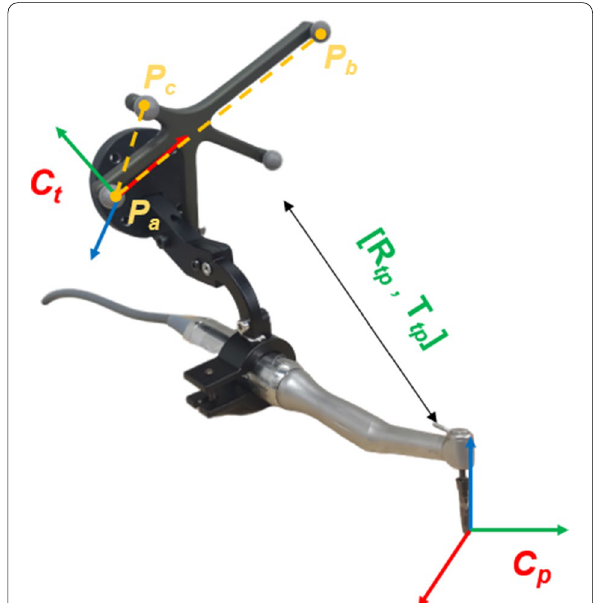
Figure 3 Surgical tool coordinate system established by three non-collinear retro-reflective markers